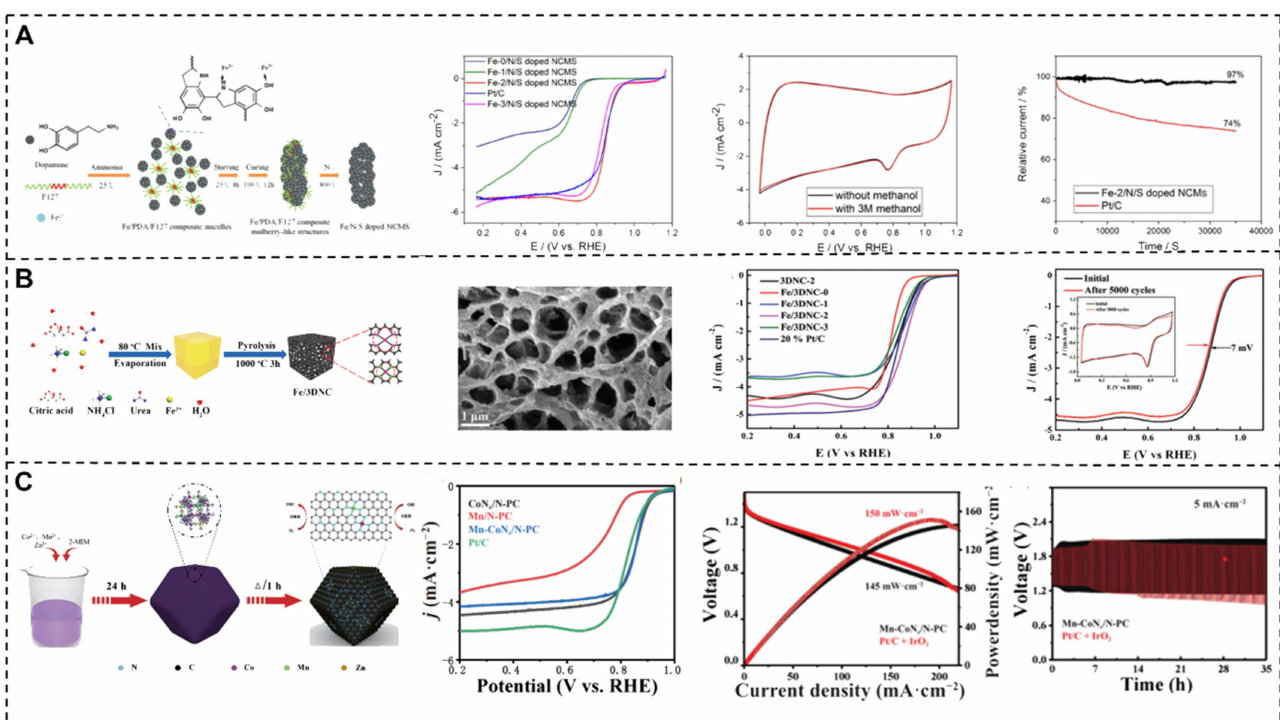
Figure 5. ( A ) Schematic illustration of the preparation of the Fe/N/S-doped NCMs, and LSV curves, and methanol tolerance tests, and chronoamperometric response [41]. ( B ) Schematic illustration of the preparation of the Fe/3DNC, and SEM images, and LSV curves, and comparison of ORR polarization curves before and after 5000 cycles [42]. ( C ) The preparation process of Mn-CoNx/N-PC, ORR polarization curves, the power density and charge-discharge testing of Mn-CoNx /N-PC